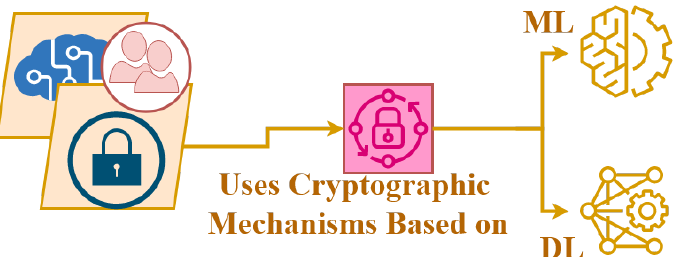
Figure 6. AIRC: Uses Cryptographic Mechanisms Based on ML and